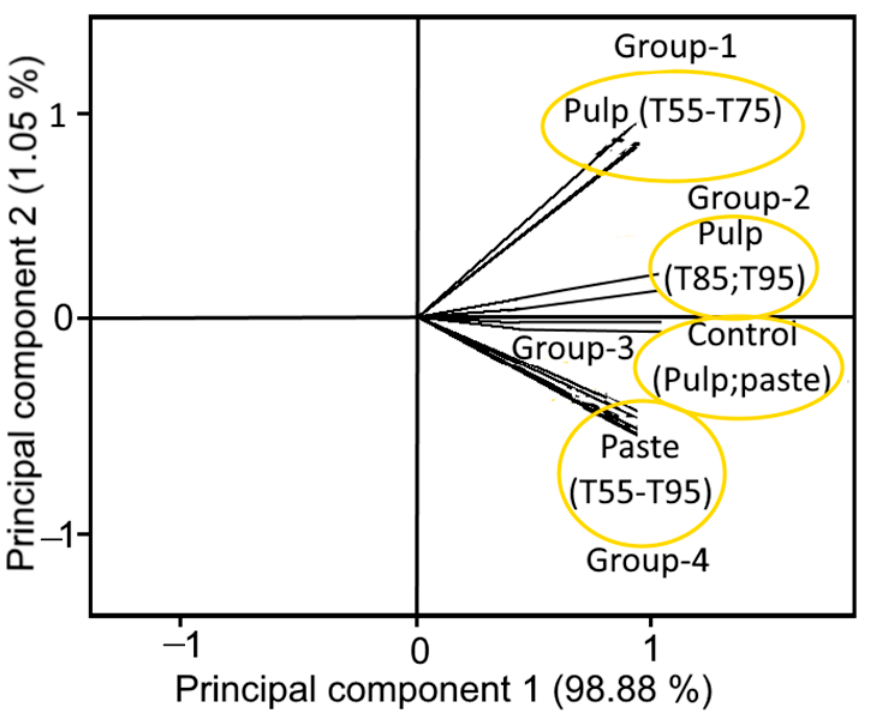
Figure 7. Loading plot of the first two principal components of tomato samples as affected by cold- and hot-break heat treatments. T55 and T95 represent coded temperature values for cold- and hot-break heat treatments.